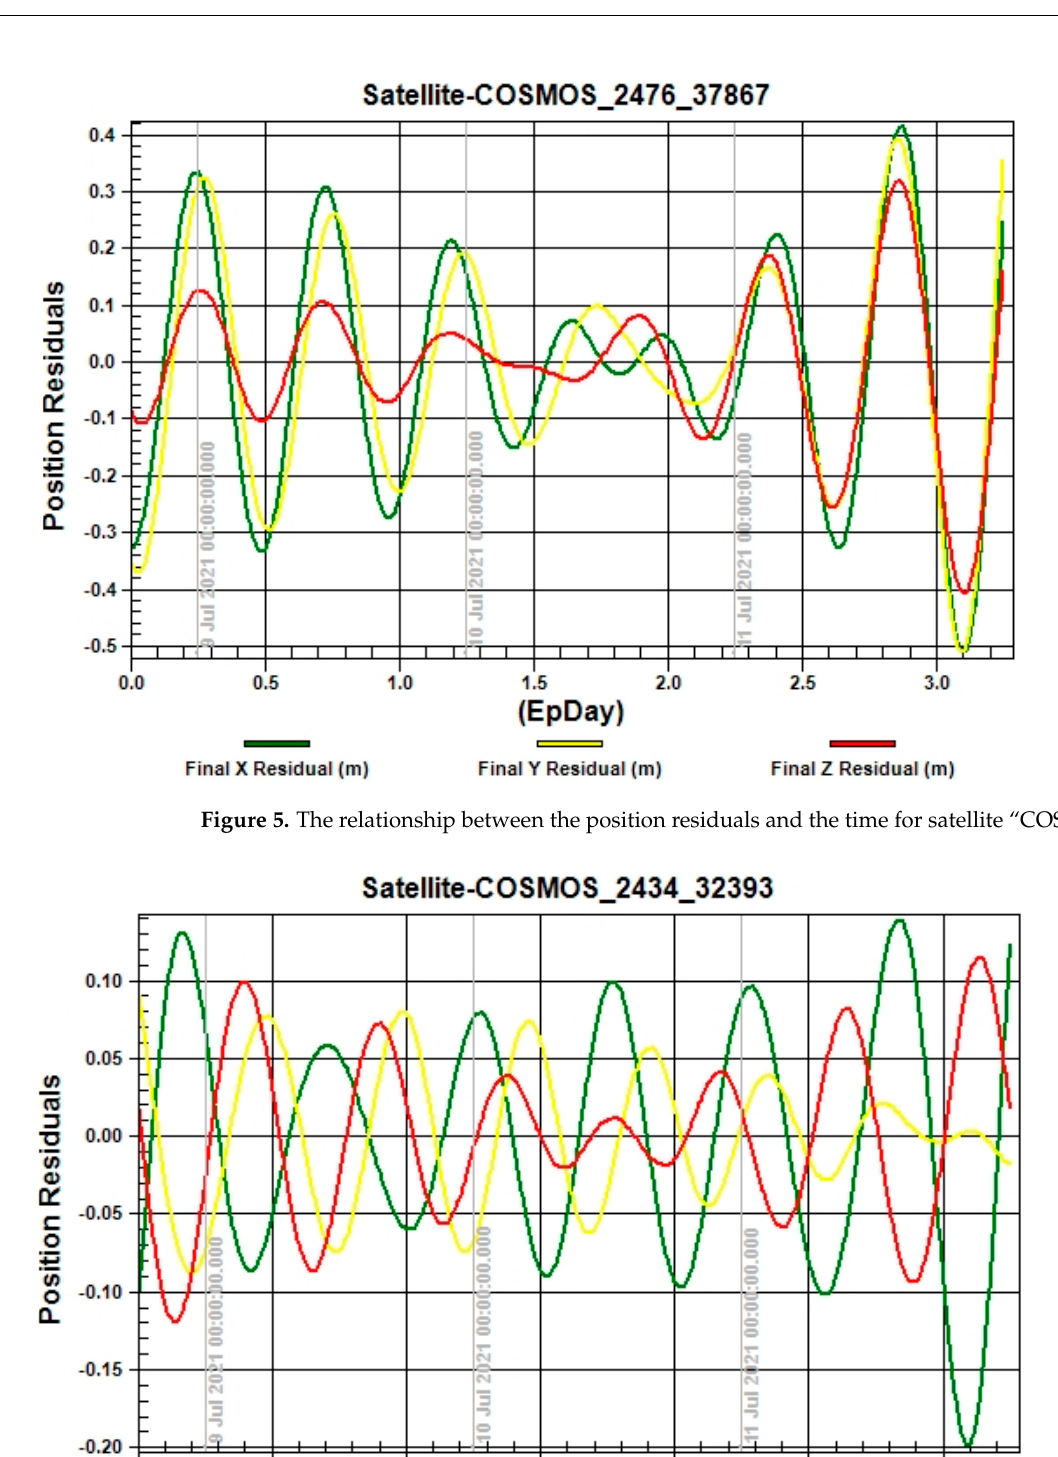
Figure 4. The relationship between the position residuals and the time for satellite“COSMOS- 2464”.